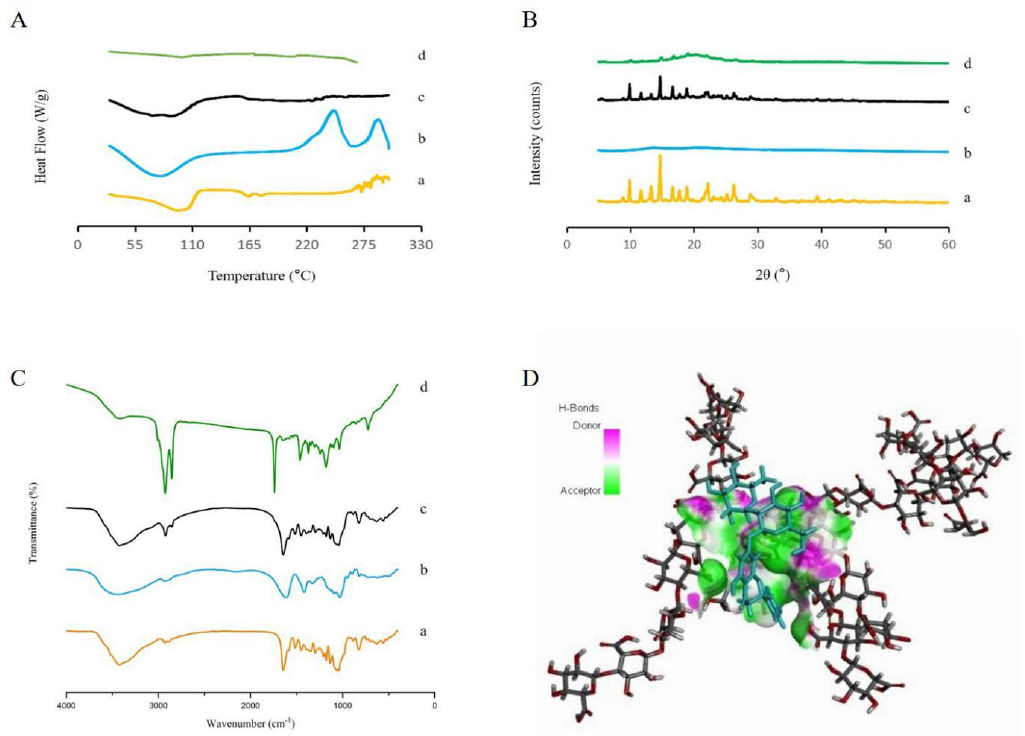
Figure 4. Characterizations of ( A ) DSC thermograms, ( B ) XRD patterns, and ( C ) FTIR spectra. Nar- ingin (a), SA (b), PM (c), and microspheres (d). ( D ) The 3D conformations of SA and naringin by molecular docking (hydrogen bonding in green, O atoms in red, C atoms in gray, and naringin in blue).